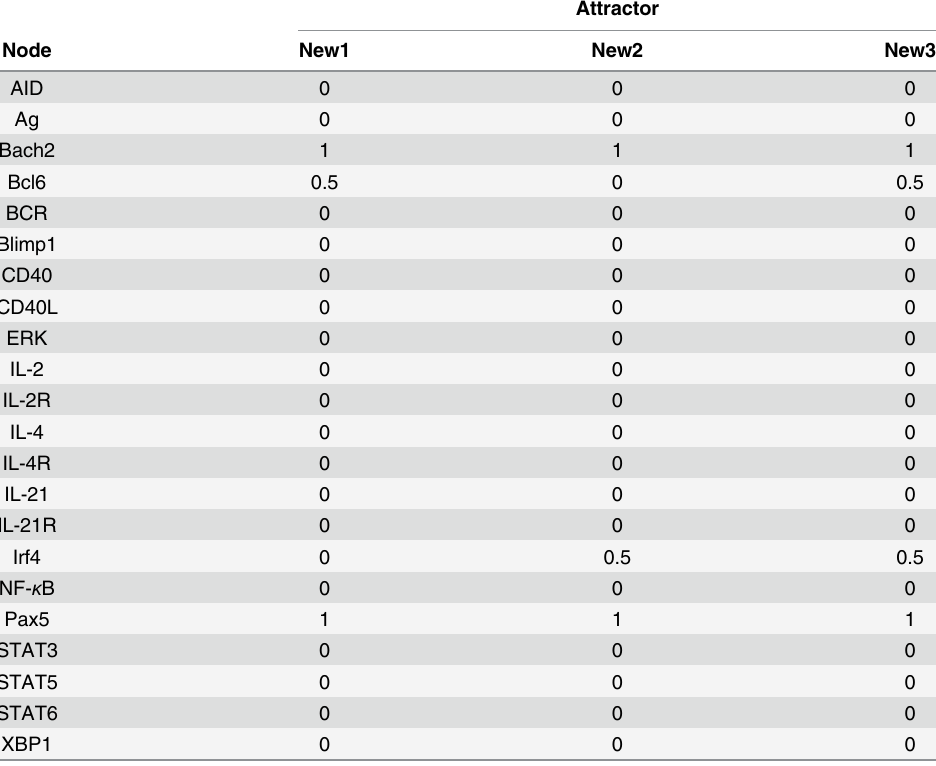
Three fi xed point attractors were found with the perturbation analysis that has not been found in the random search. These attractors are characterized by intermediate values of the